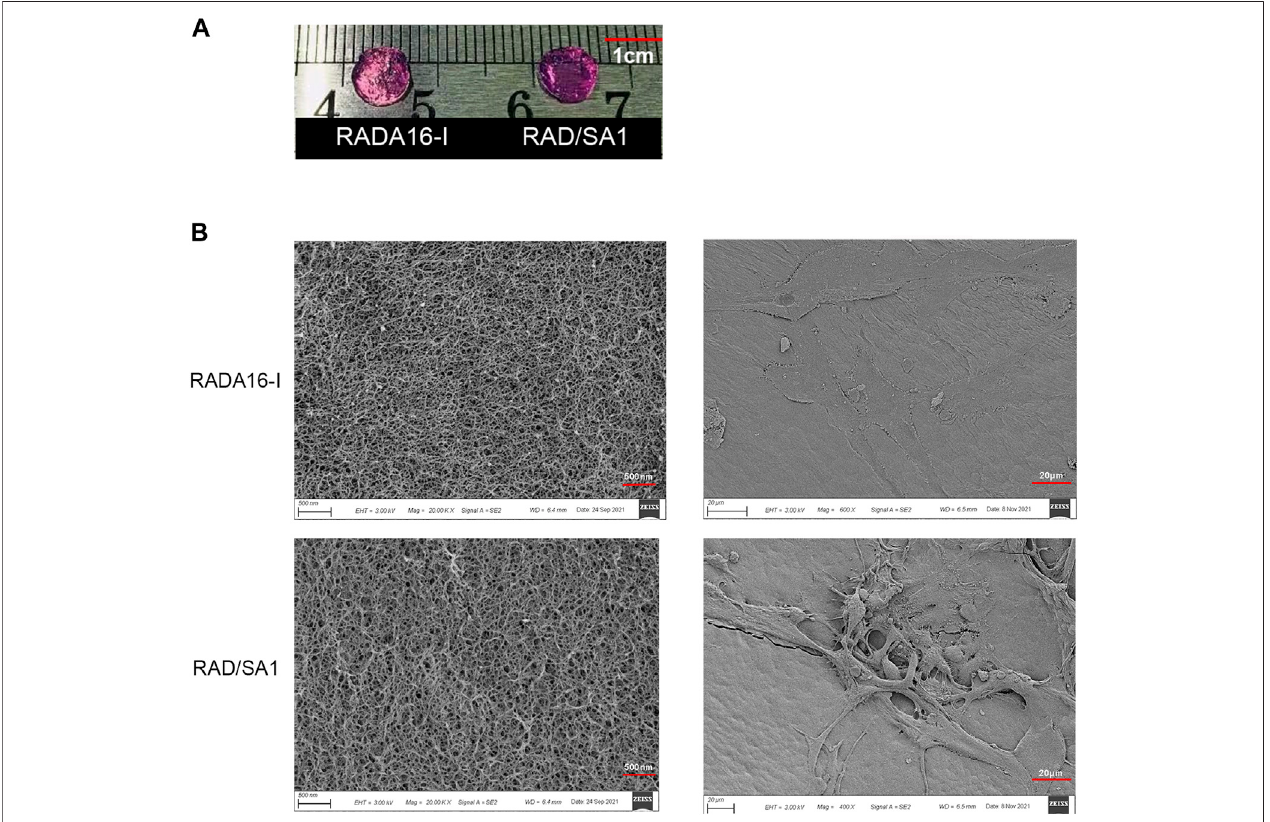
FIGURE1|(A) BothRADA16-IandRAD/SA1formedatransparenthydrogel-likematerialat37 ° C invitro . (B) TheSEMimagesshowedthatallofthedesignerself- assembling peptides had formed nano fi bers that had interwoven to form porous structures and that the hNPMSCs had attached to the nano fi bers by extending many